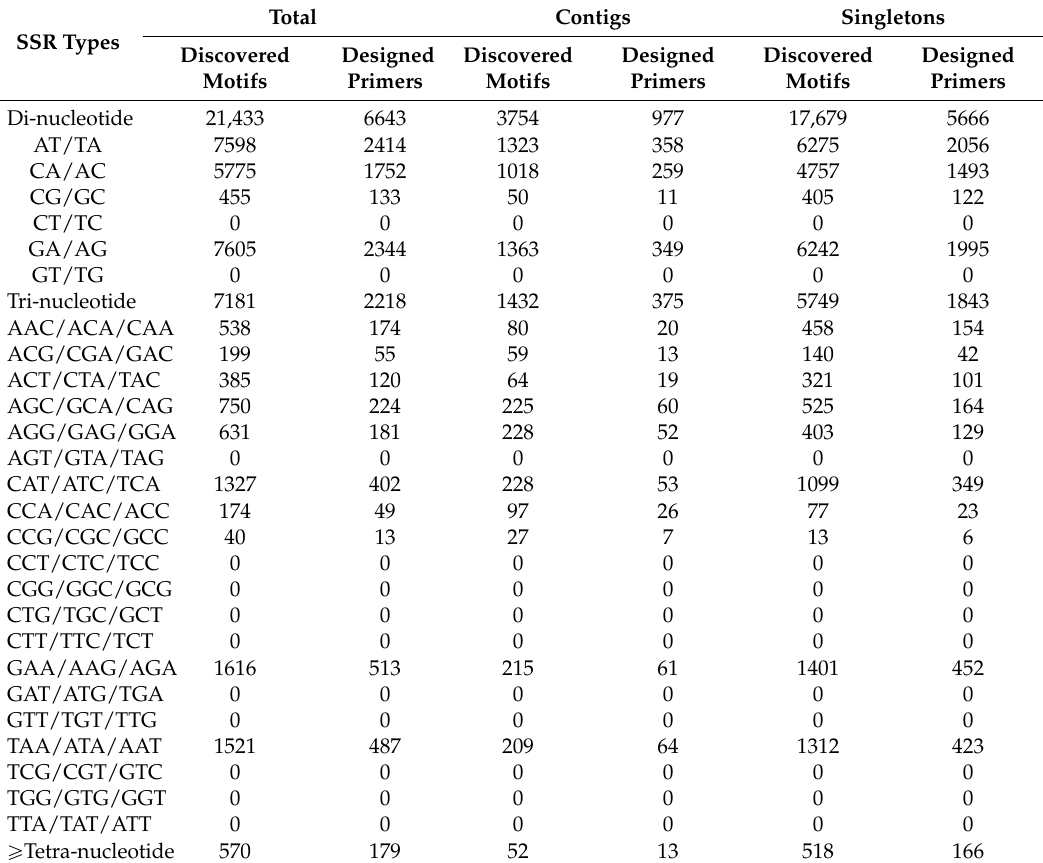
Table 5. Summary of putative simple sequence repeat (SSR) nucleotide classes among different nucleotide types. Both contig and singleton sequences were used to predict SSR